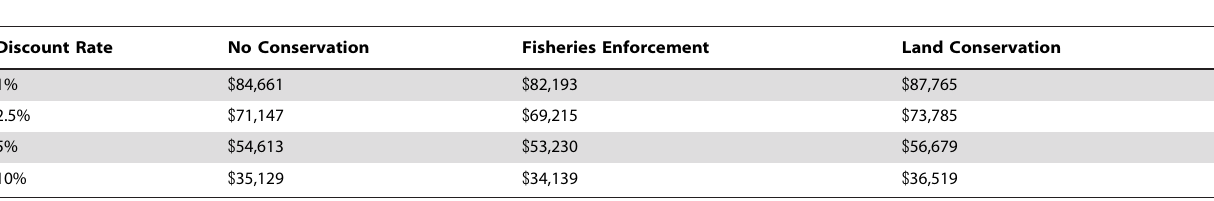
Table 2. Present value of all future income for an individual worker with the different conservation actions.